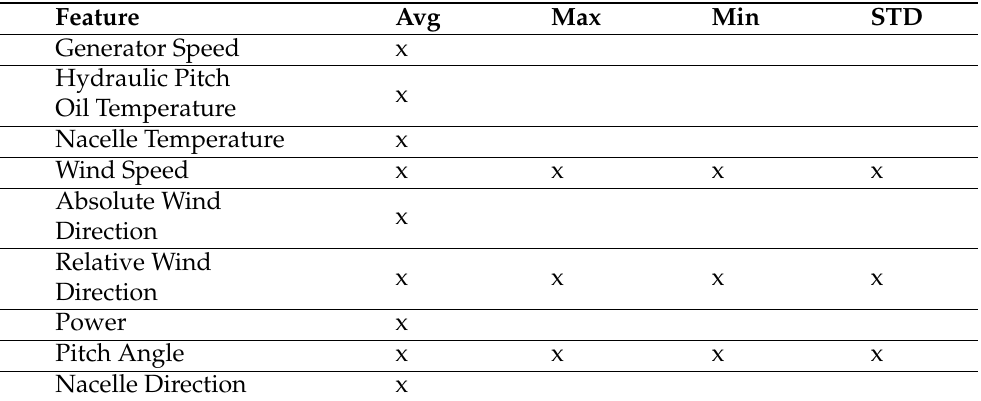
Table 2. Features provided in the data for Case Study